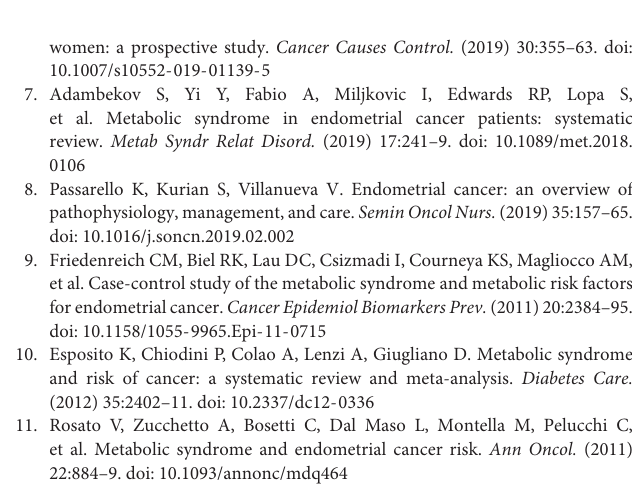
Supplementary Figure 1 | ANOVA analysis revealed significant differences in endometrial cancer prognostic-related metabolic (ECPRM) Score of the free metabolic disorder in patient (FMDP), partial metabolic disorder patient (PMDP), and metabolic syndrome in patient (MetSP) group in the